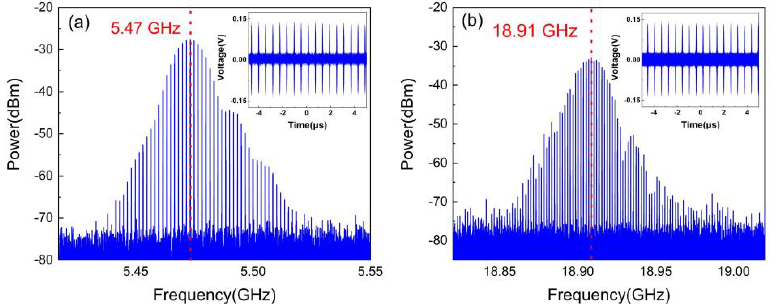
Figure 5. Frequency spectra of the generated microwave pulses with different center frequency: ( a ) 5.47 GHz, ( b ) 18.91 GHz.